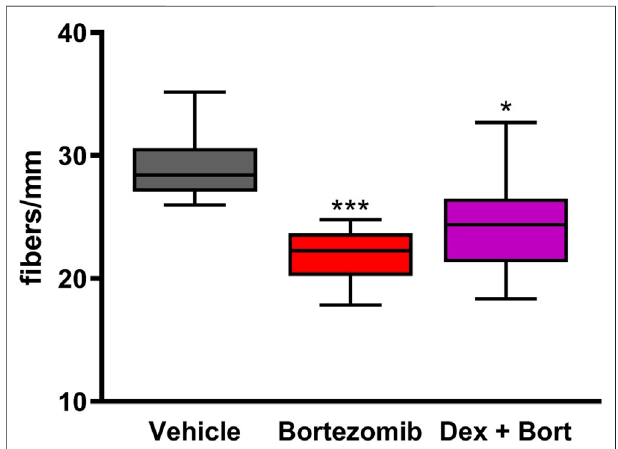
FIGURE 6 | Ef fi cacy of dexanabinol on bortezomib-induced decreases in intraepidermal nerve fi ber (IENF) density. IENF density was measured at the end of the 8 weeks of drug treatment by an immunochemistry analysis using PGP 9.5. GraphPad prism v7.04 was used to perform a Kruskal-Wallis test with Dunn ’ s correction for multiple comparisons across all groups. Only signi fi cant comparisons to vehicle are displayed. p values are reported as: * ( < 0.05), *** ( <